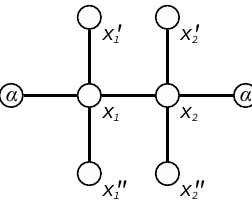
Fig. 3: A partially colored tree. The tree T may have an additional leaf v colored β that is not